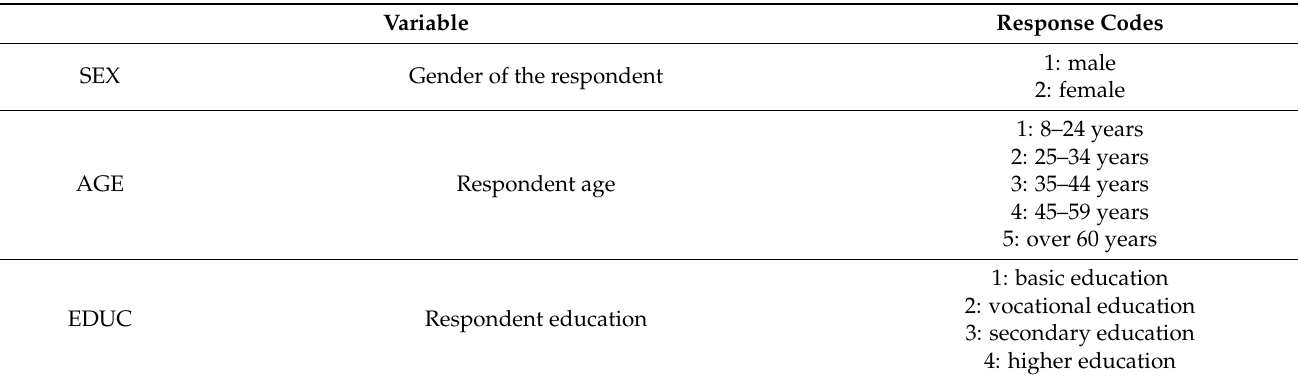
Table 2. Response